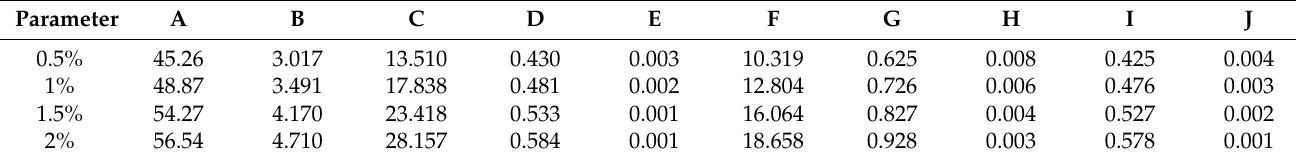
Table 7. Improved K&C material model parameters for steel fiber concrete.